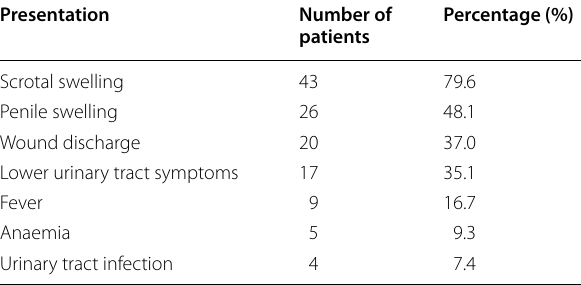
Table 1 Presentations of patients with peno‑scrotal wound